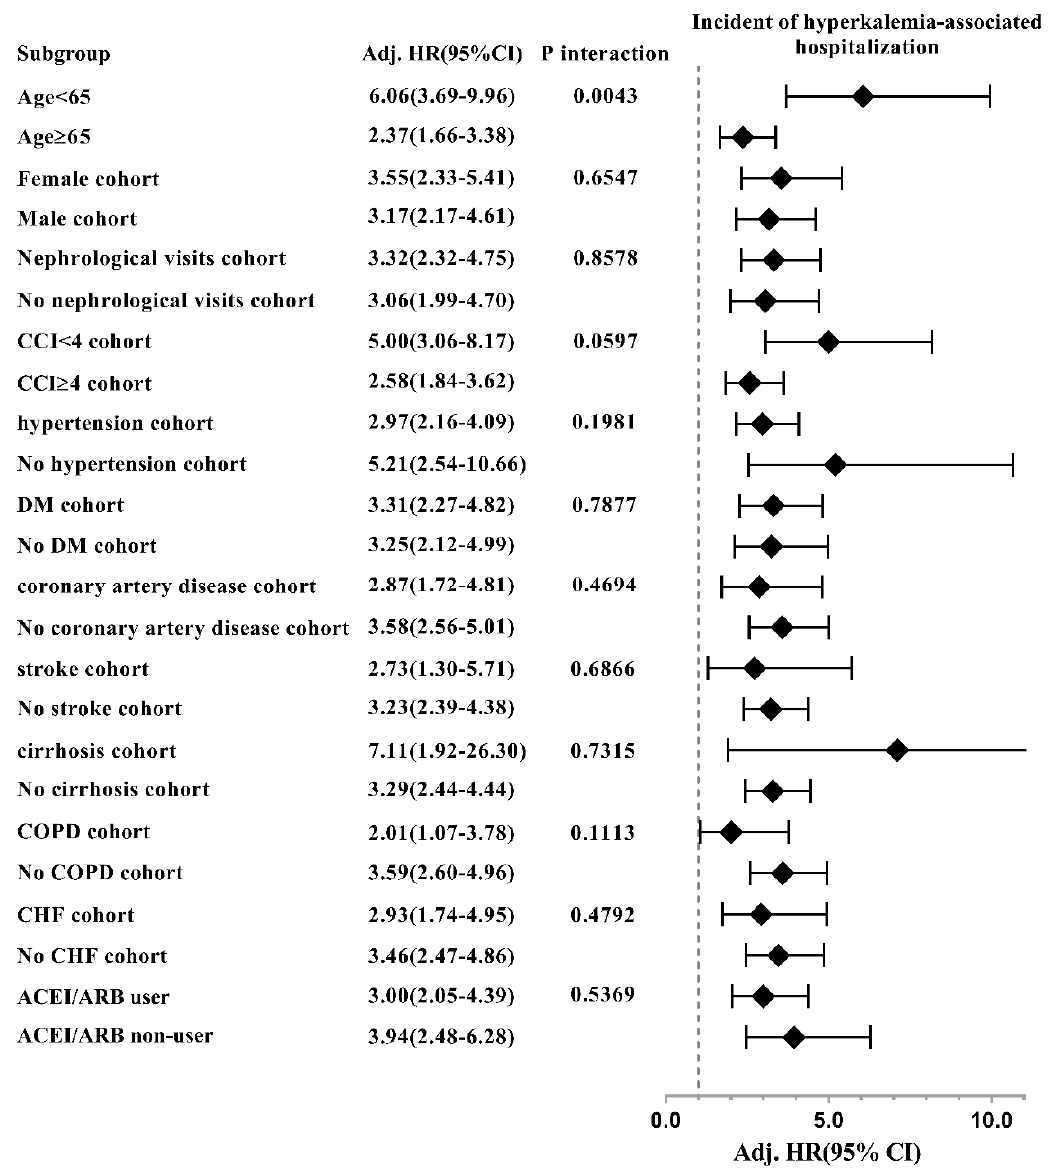
Figure 7. Hazard ratios of progression to hyperkalemia-associated hospitalization associated with spironolactone use in subgroup analyses.